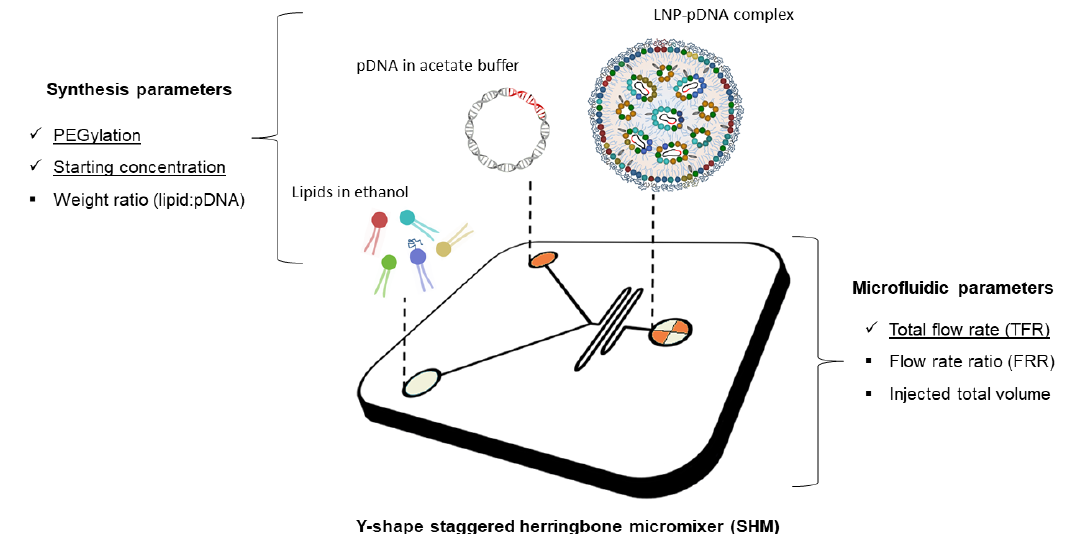
Figure 1. Schematic of lipid nanoparticle-plasmid DNA (LNP-pDNA) complex formulation strategy employing the staggered herringbone micromixer (SHM). Lipids in ethanol are injected in one inlet, while pDNA dissolved in acetate buffer solution is injected in the other inlet. The two solutions meet at the Y-junction of the SHM and undergo a chaotic mixing through the herringbone structure. This phenomenon leads to an increase of lipid solution polarity that generates LNPs encapsulating pDNA. On the sides of the image, two main categories of influential manufacturing factors are reported, i.e., synthesis and microfluidic parameters. Among these, those underlined are the ones that are investigated in the present